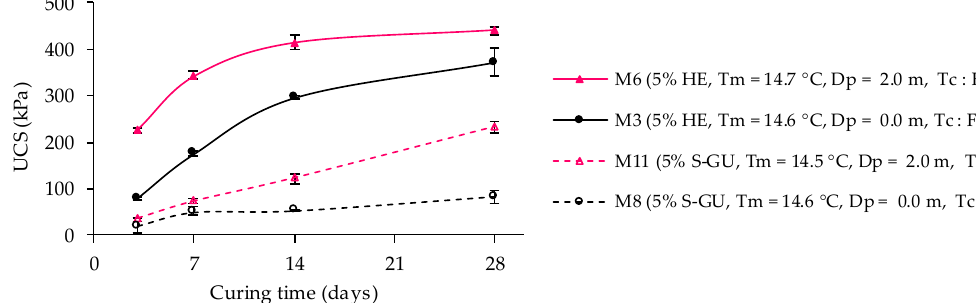
Figure 5. Comparison of the evolution of the UCS of CPB samples containing 5% HE (full lines) and S-GU (dashed lines) cured at decreasing temperatures depending on the distance from the CPB–permafrost wall interface (Dp): 0 m (M3 and M8) and 2 m (M6 and M11).